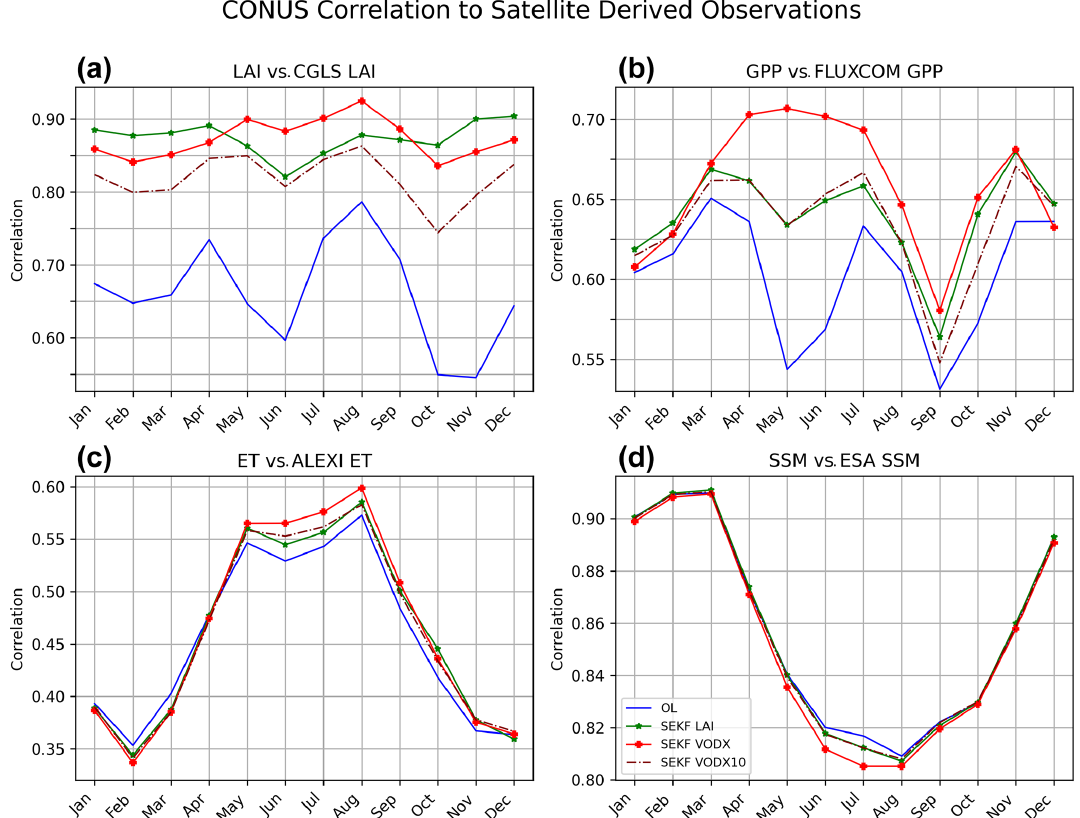
Figure 7. Graphs of monthly correlations over CONUS between the LDAS-Monde OL (solid blue line), SEKF LAI (solid green line with star markers), SEKF VODX (solid red line with cross markers), and SEKF VODX10 (dash-dotted maroon line) and satellite-derived observations of (a) LAI (2003 to 2018), (b) GPP (2003 to 2013), (c) ET (2003 to 2018), and (d) SSM (2003 to